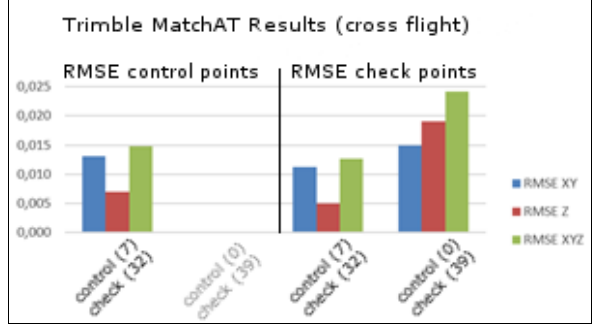
Figure 8: RMSE values [m] of GCP and CP as shown in table 2 and 3